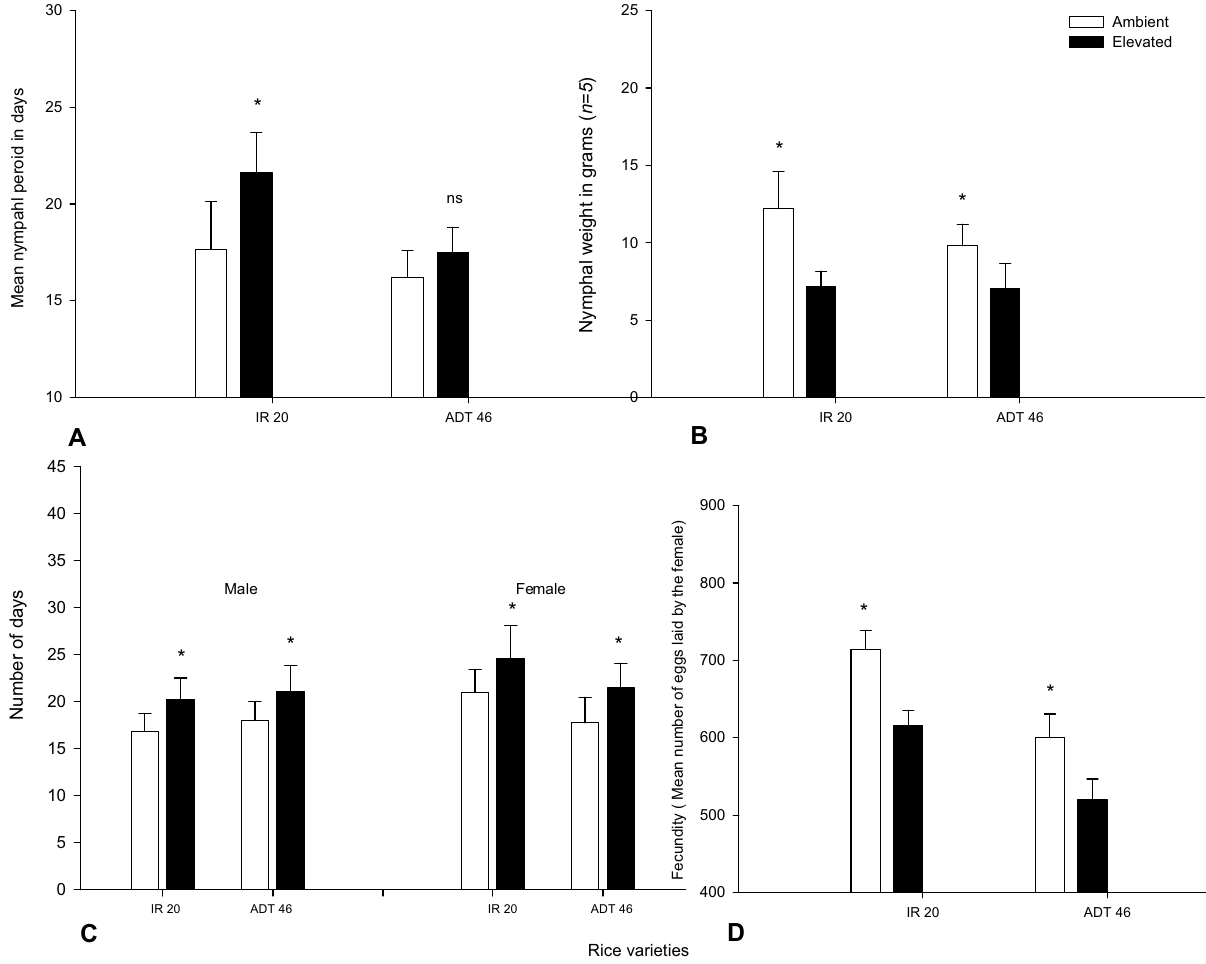
Figure 8. Mean nymphal period, nymphal weight and adult longevity of N. lugens in ambient and elevated condition (Mean (± SEM) followed by the symbol * in an individual experiment indicate significant difference (P < 0.05) in a Tukeys test) (ns-non